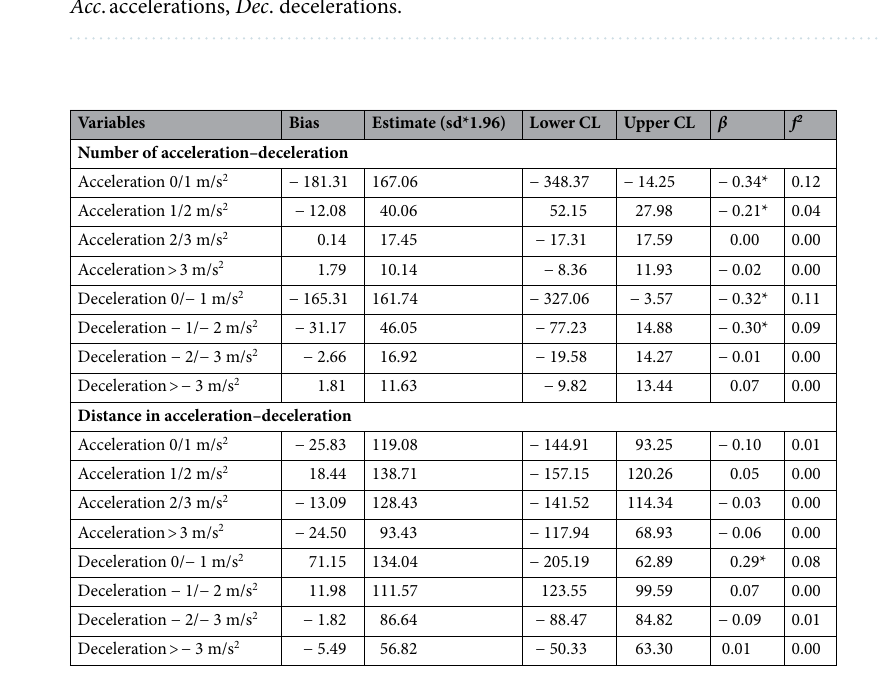
Table 2. Bland and Altman 95% confidence limits of the number and the distance covered in different accelerations and decelerations sections.